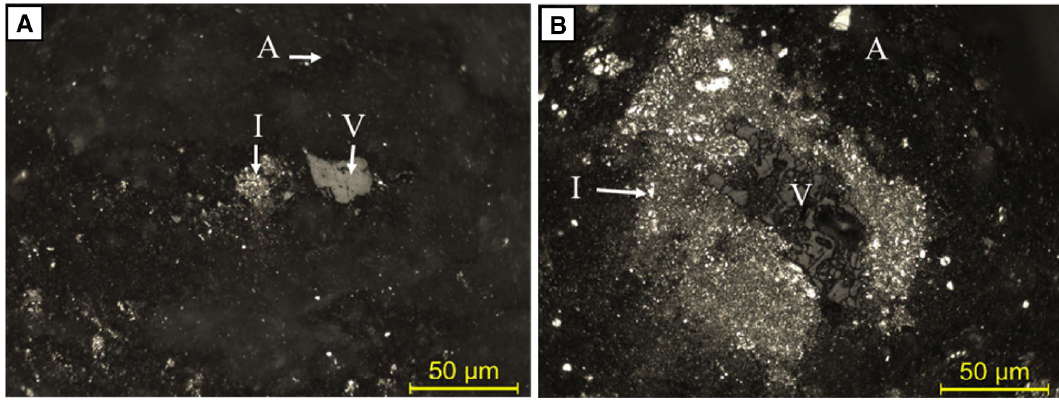
Fig. 4 Microphotographs of organic matter observed in the Upper Sargelu zone samples A (depth 5160 m) and B (depth 5,175 m); vitrinite (V), amorph (A), and inertinite (I)